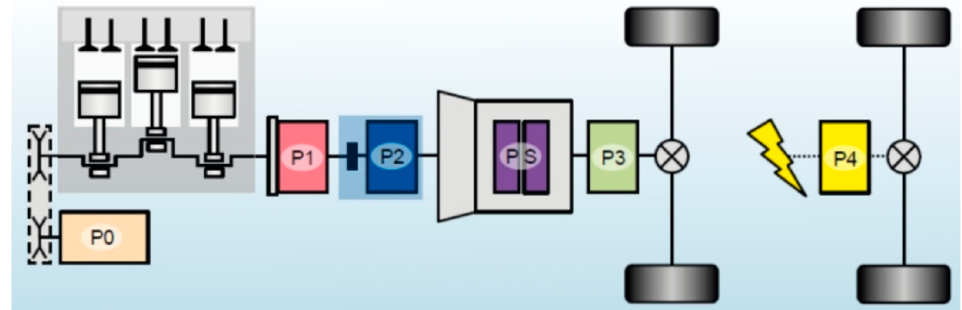
Figure 1. Classification of parallel hybrid powertrains based on the position of the electric motor (Px) in the transmission line [2].